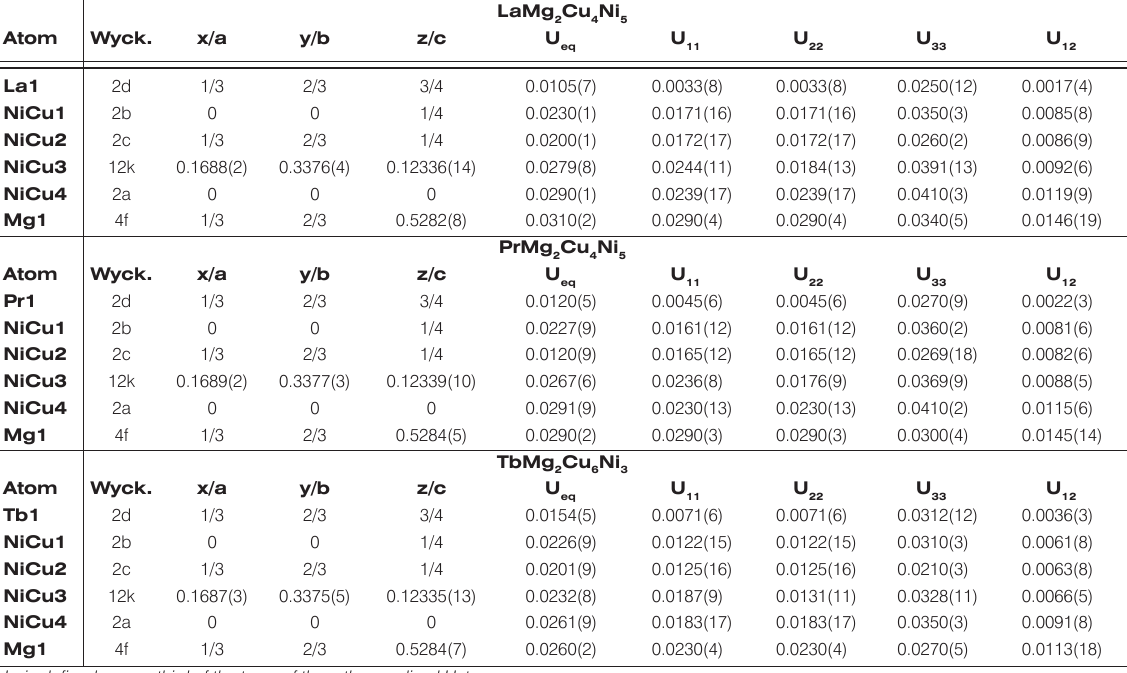
Cu Ni , PrMg Cu Ni and TbMg 2 4 5 2 4 5